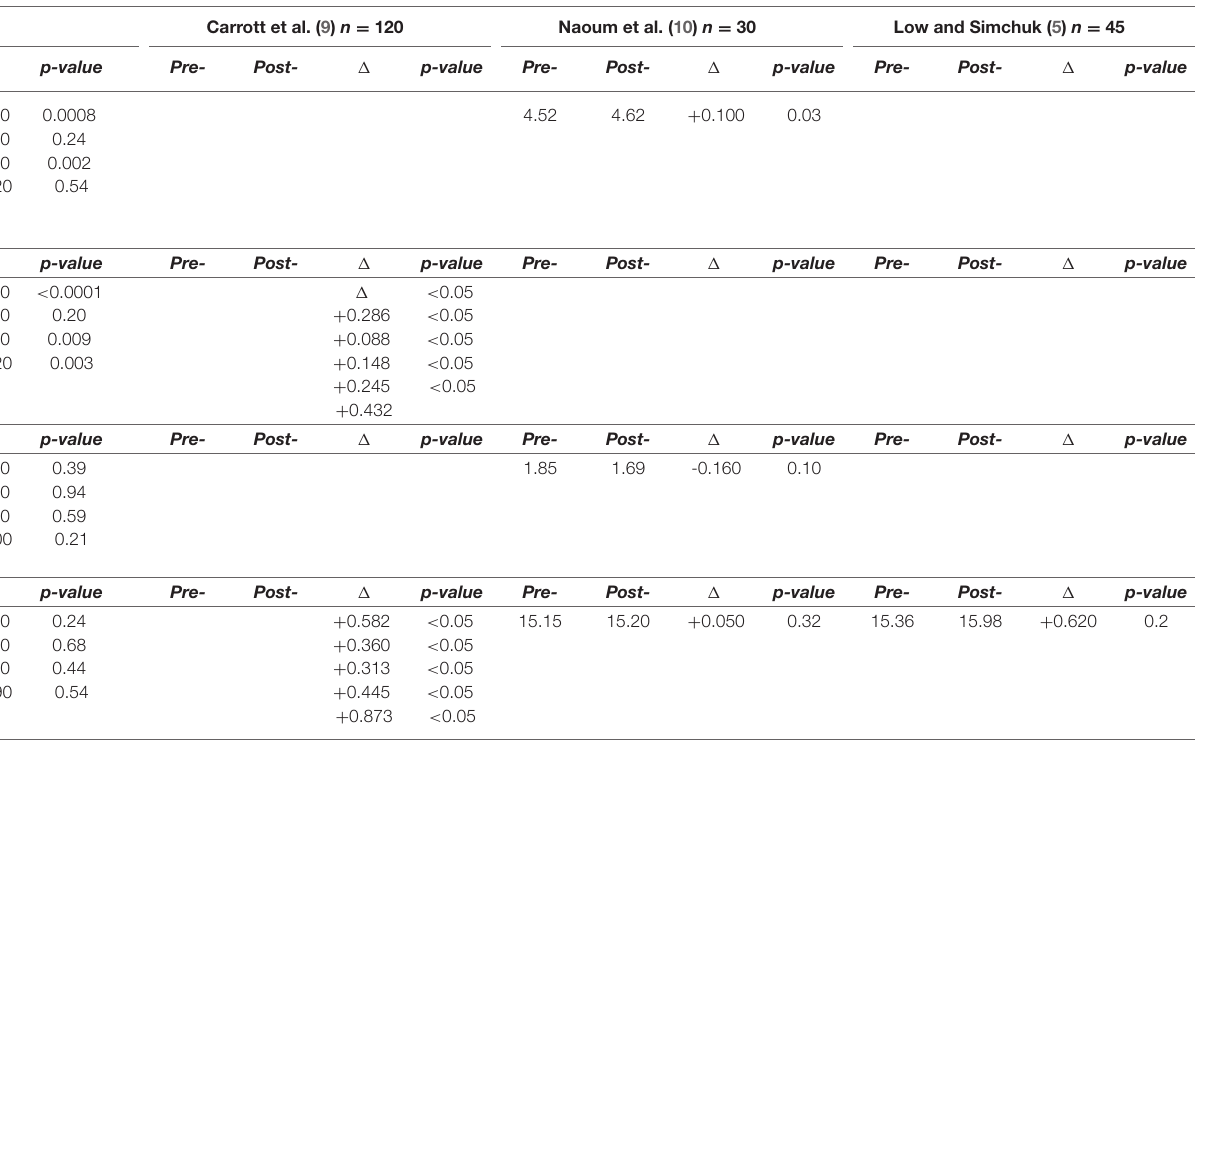
TABLE 2 | Lung volumes and diffusion